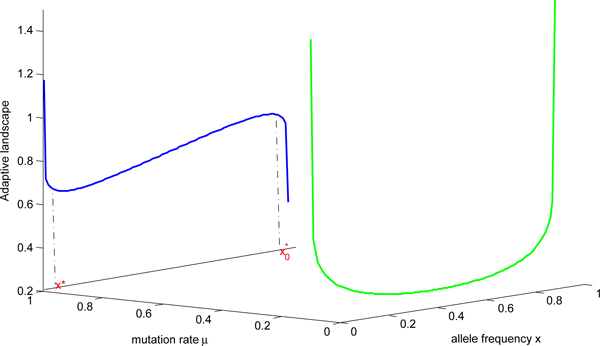
Adaptive landscape with two adaptive states. N=50, blue line represents μ=0.02,σ=0.05 corresponding the case for I iv) while green line stands for μ = 0.000005, σ=0.00005 corresponding the case for I iii).